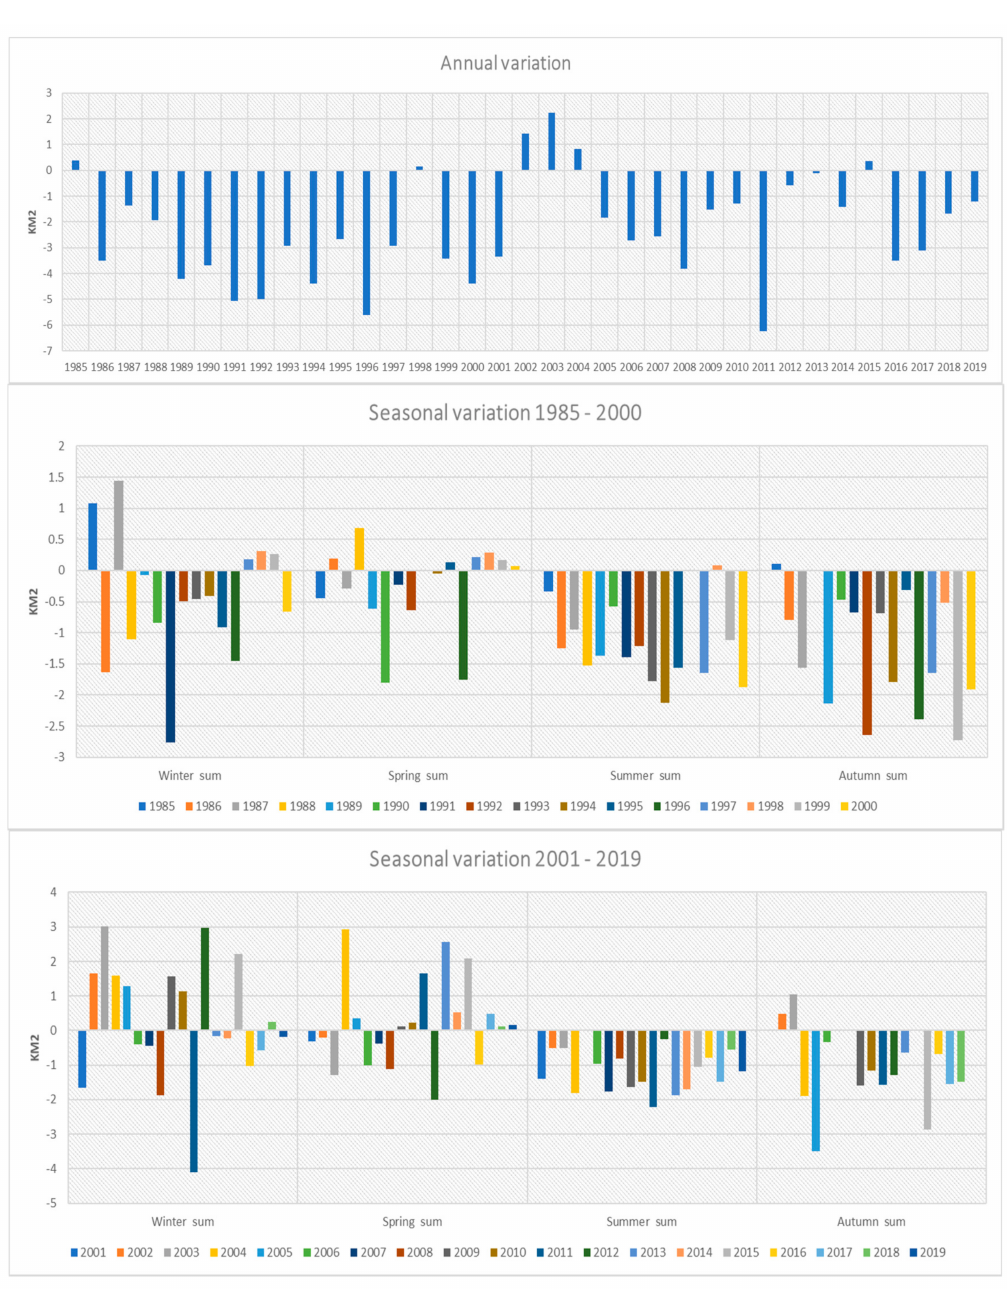
Figure 6. Seasonal and annual temporal redaction variation between 1985 and